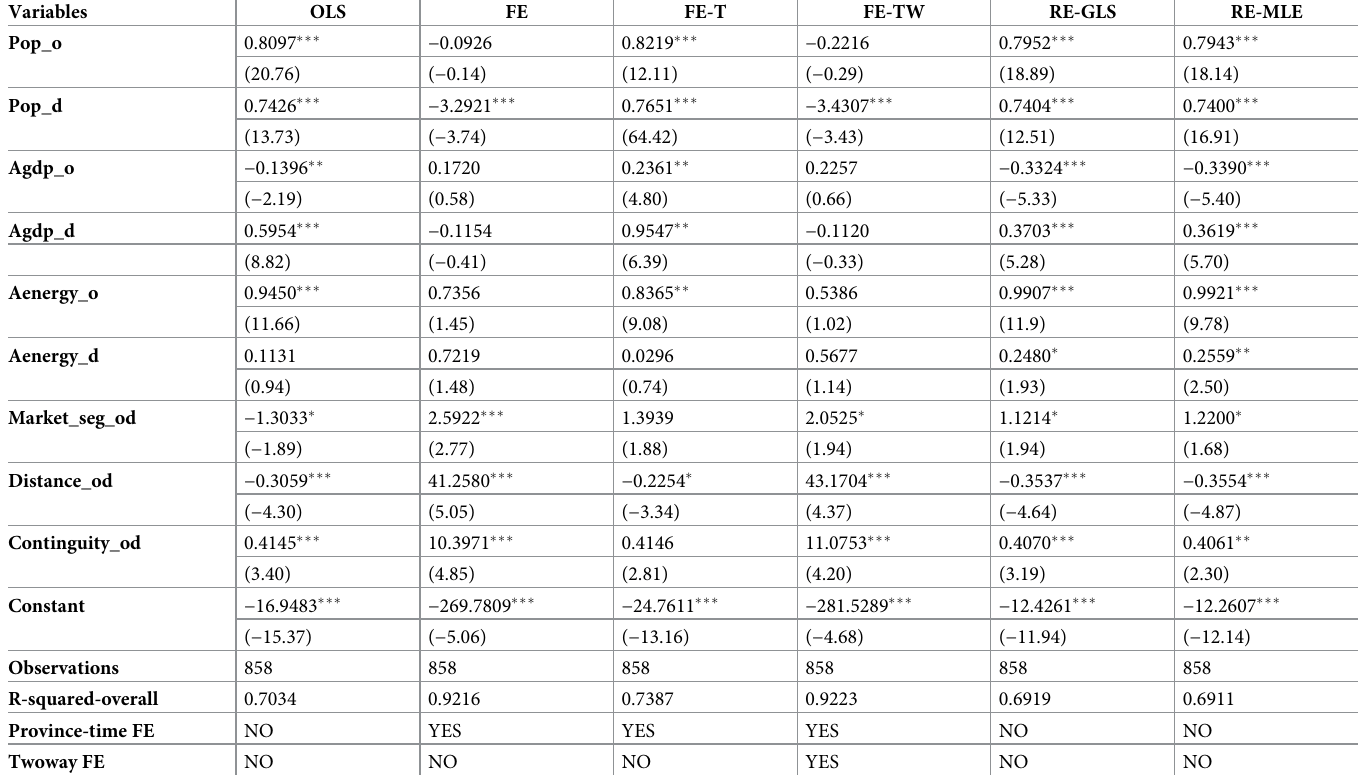
Table 6. The gravity estimated results using interprovincial embodied CO 2 flows between Eastern and Western China.